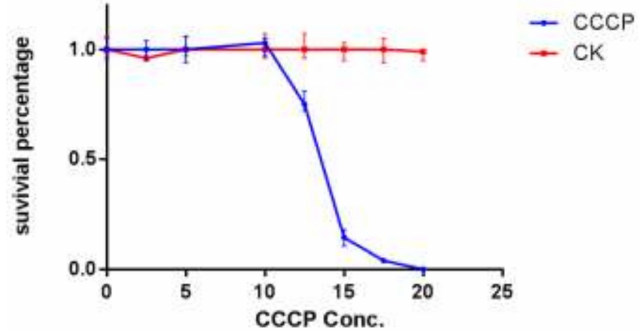
Figure 1. Minimum bactericidal concentration test of the uncoupler CCCP (carbonyl cyanide m-chlorophenyl hydrazine) to Smal-007. The survival rate of Stenotrophomonas maltophilia Smal-007 after 48 h of exposure to CCCP at different concentrations were recorded. CK represents survival rate of control group without CCCP. X-axis represents concentration of CCCP ( µ g/mL) and Y-axis represents the survival rate of